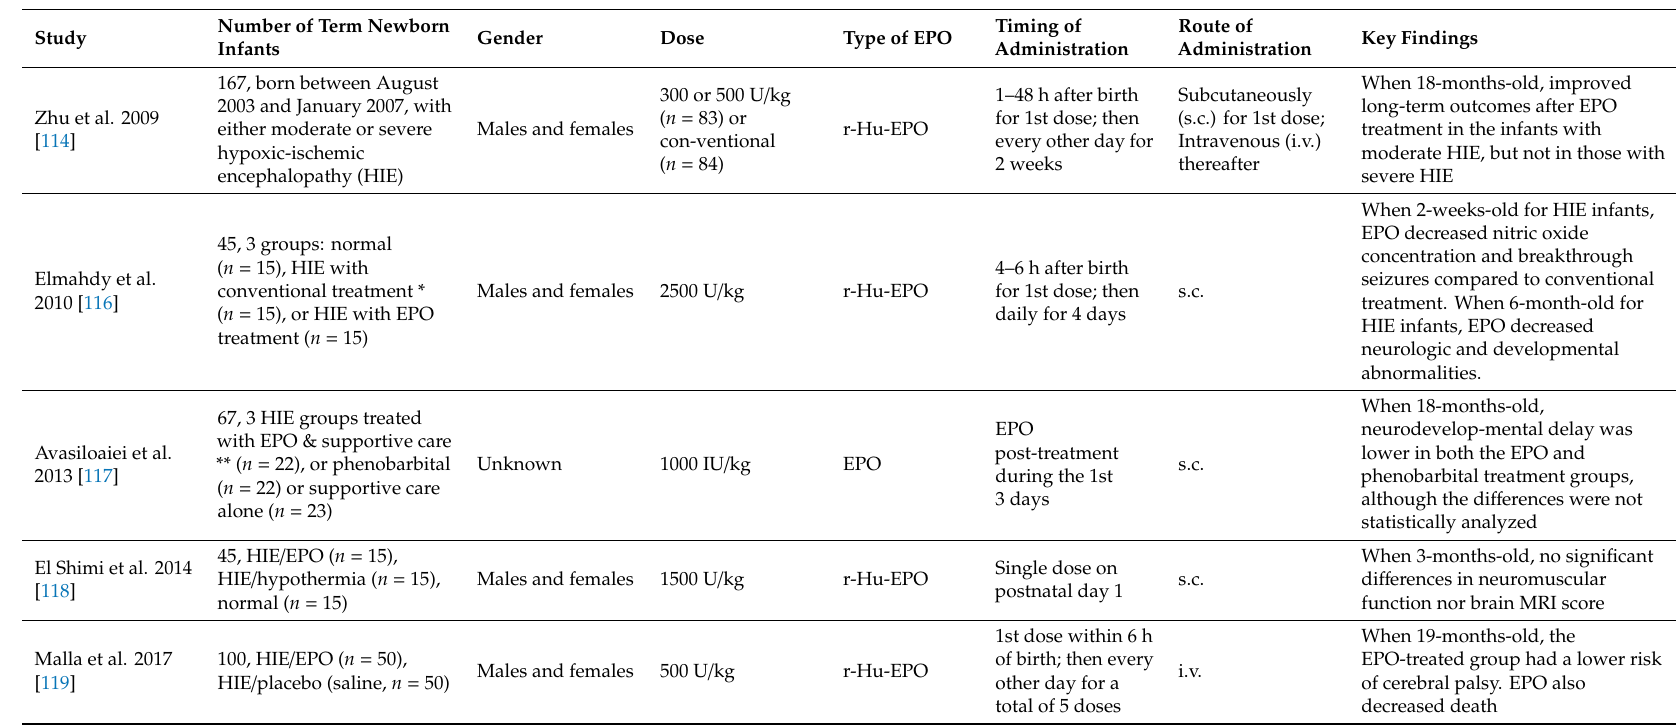
Table 3. Clinical studies on neonatal hypoxic-ischemic encephalopathy: E ff ect of EPO